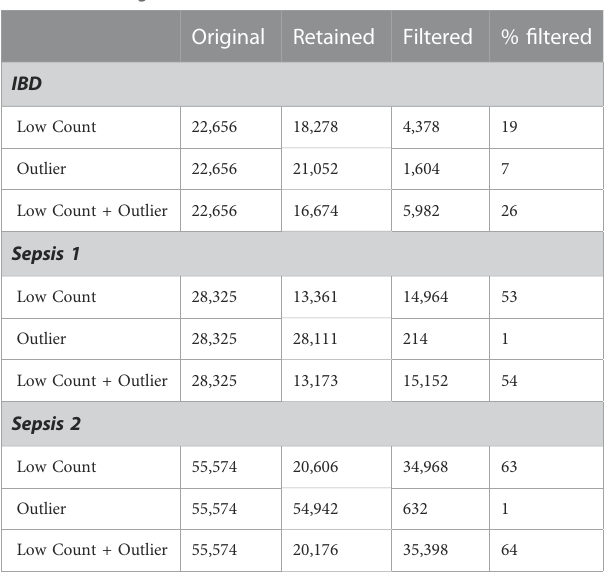
TABLE 1 Filtered genes.